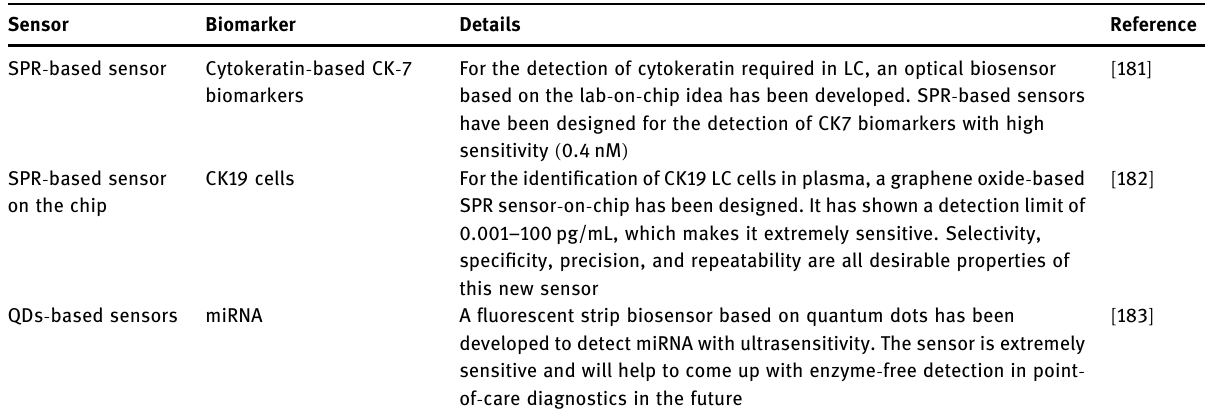
Table 4: Optical biosensors in LC detection [ 10 ]